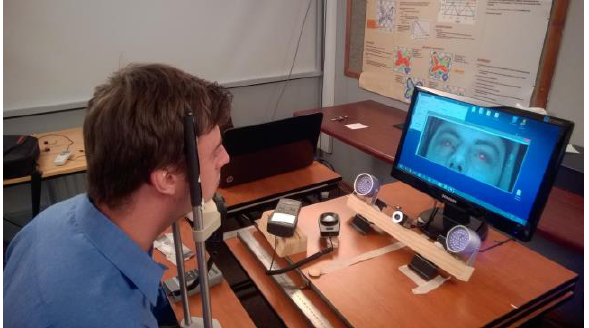
Figure 3: Laboratory setup with the participant on a fixed chin rest and the eye tracker and monitor on an XYZ adjustable